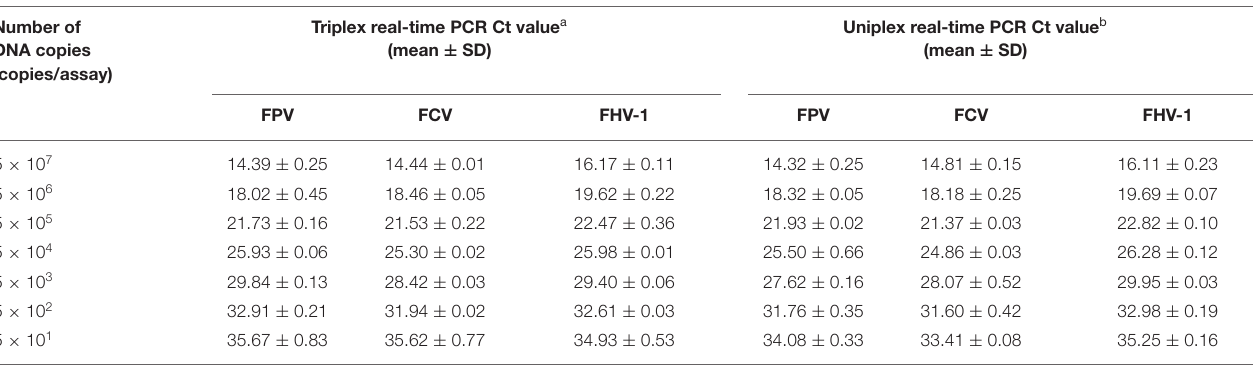
TABLE 2 | Sensitivity of the real-time